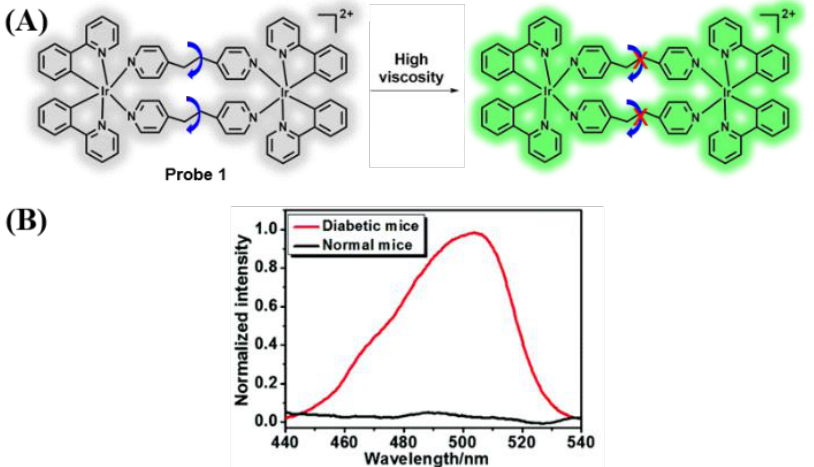
Figure 2. ( A ) Imaging mechanism of probe 1 ; ( B ) the phosphorescence spectra of probe 1 in the fresh blood of normal and diabetic mice, respectively, λ ex = 405 nm. Adapted from Reference [54]. Copyright 2019, the Royal Society of Chemistry.